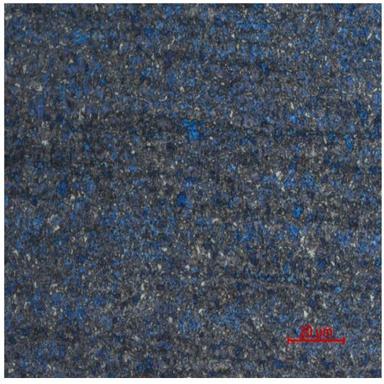
Microstructure of steel revealed through Klemm I colour tint etching. The ferritic phase was stained with beige, bainite, and martensite, which remained indistinguishable – dark navy blue. The austenite grains and martensite-austenite isles remained white. The average grain size was between 1 and 3 µm.